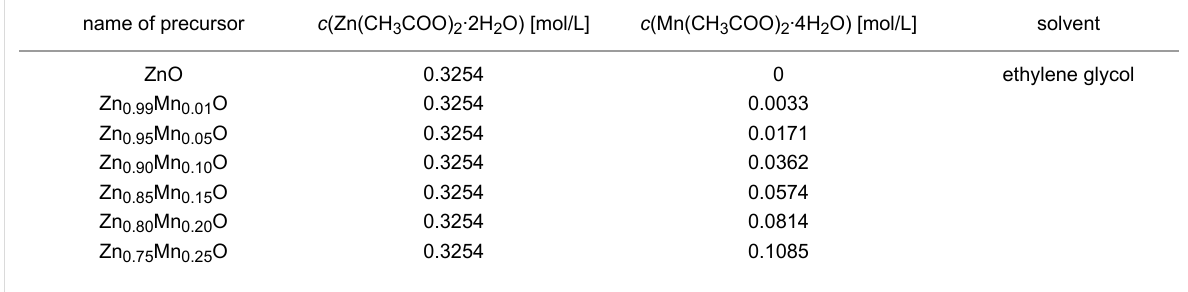
Table 1: Composition of precursors of Zn 1 − x Mn x O